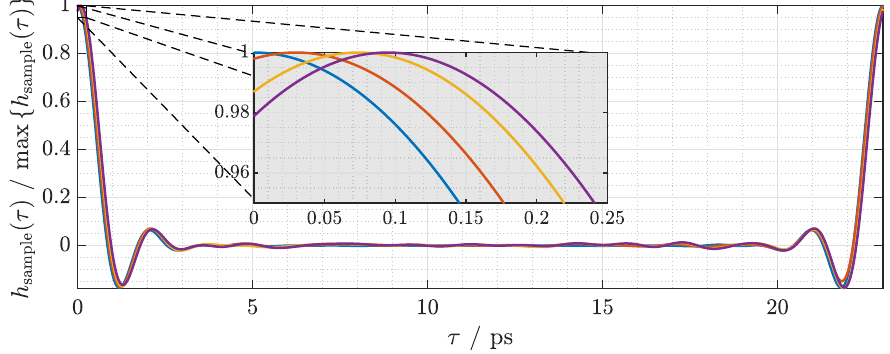
Figure 12. Impulse response of 0–3 layers of cling